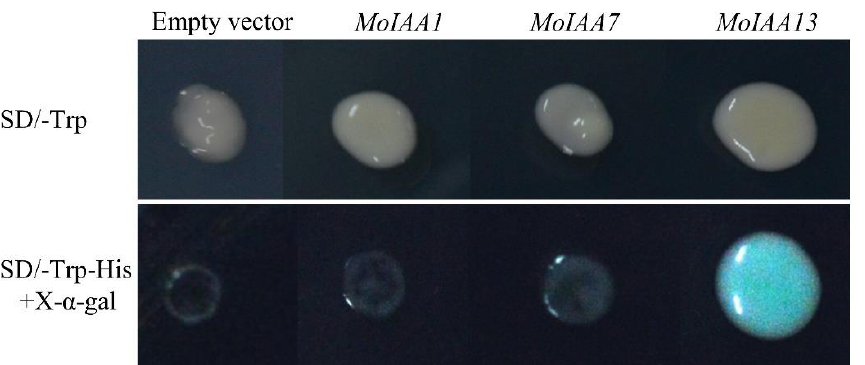
Figure 9. Analyses of transcriptional activation activity of the MoIAA1 , MoIAA7 and MoIAA13 encoding proteins.